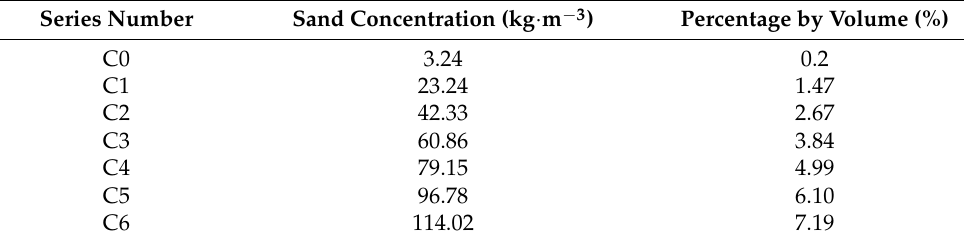
Table 2. The sand concentration in different